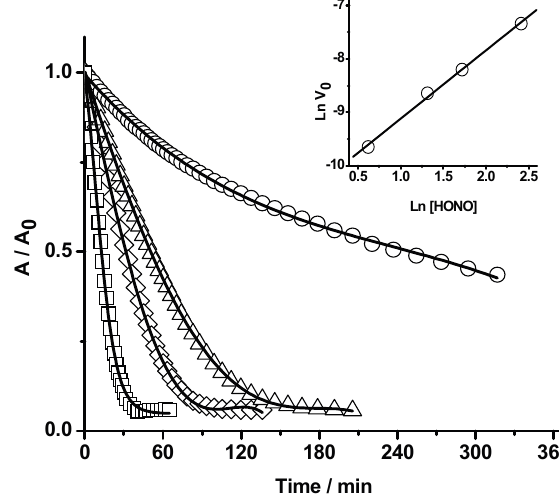
Figure 3. Influence of HONO concentration on the PGR bleaching. [HONO] = 2 μ M ( ○ ), 3 μ M ( Δ ), 6 μ M ( ◊ ), and 11 μ M ( □ ). [PGR] = 22 µM. The reaction was followed at 465 nm in SGM at 37 °C. Inset: Ln(initial reaction rate, V 0 ) vs. Ln[HONO] 0